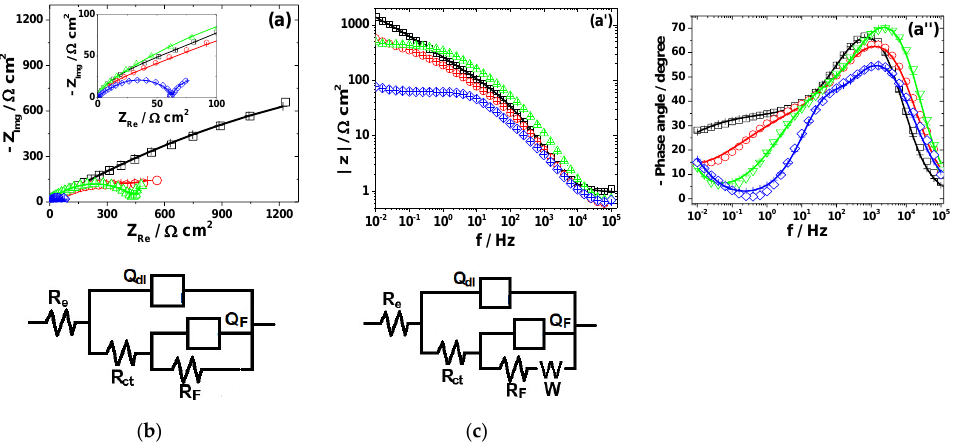
Figure 3. EIS results of Cu after immersion in different bromide-based electrolytes: Nyquist diagrams ( a ); Bode plot of | Z | vs. frequency ( a’ ); and Bode plot of phase angle vs. frequency ( a” ). The equivalent electrical circuits used to fit the EIS data ( b , c ). Symbols represent the experimental data and lines with cross (— + —) correspond to the simulated spectra. Electrolytes: ( (cid:3) ) Sol. A; (O) Sol. B; ( ♦ ) Sol. C; and ( ∆ ) Sol.